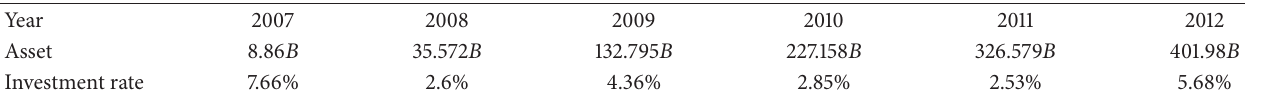
Table 11: Investment returns